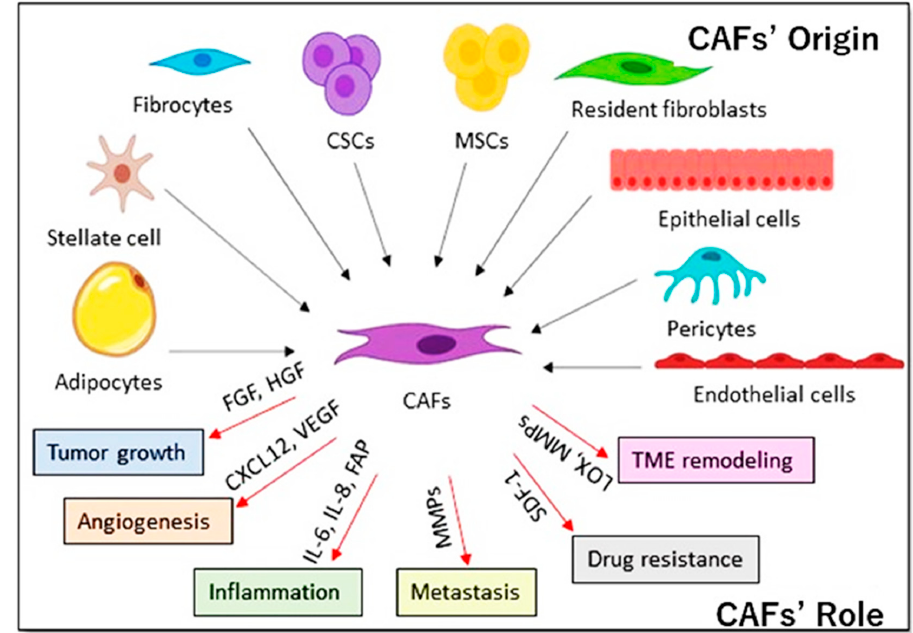
Figure 3. CAFs’ origin and role in the TME.